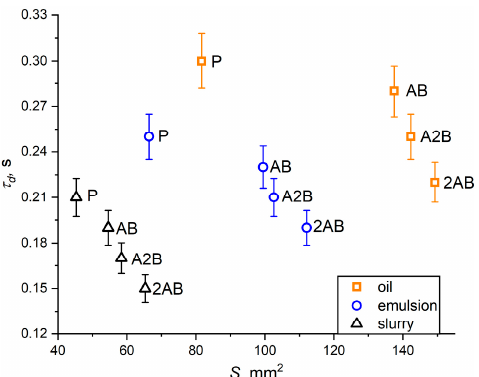
Figure 7. The ignition delay time of fuel droplets versus the projection area of the fuel droplet/heating surface interface under a mixed heat supply.